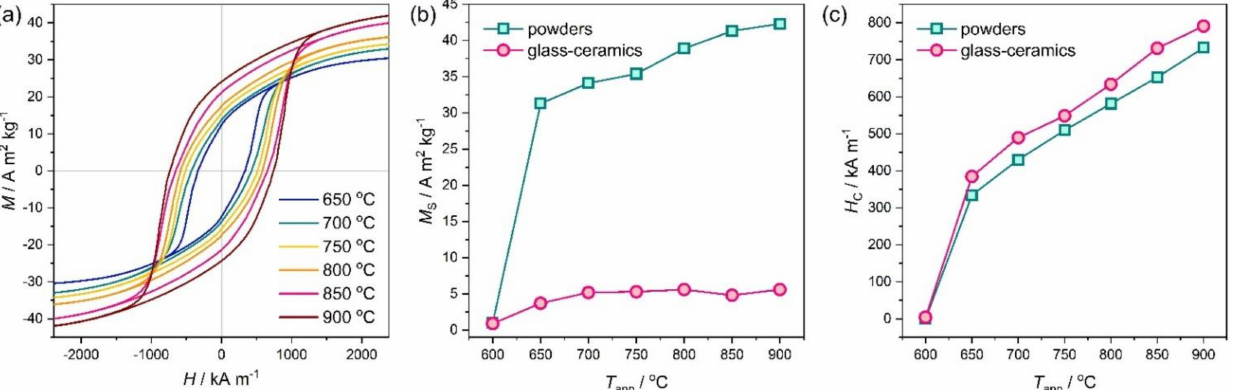
Figure 4. ( a ) Hysteresis loops of the extracted hexaferrite powders; ( b ) The saturation magnetization of the glass-ceramics and extracted hexaferrite powders; ( c ) The coercivity of the glass-ceramics and extracted hexaferrite